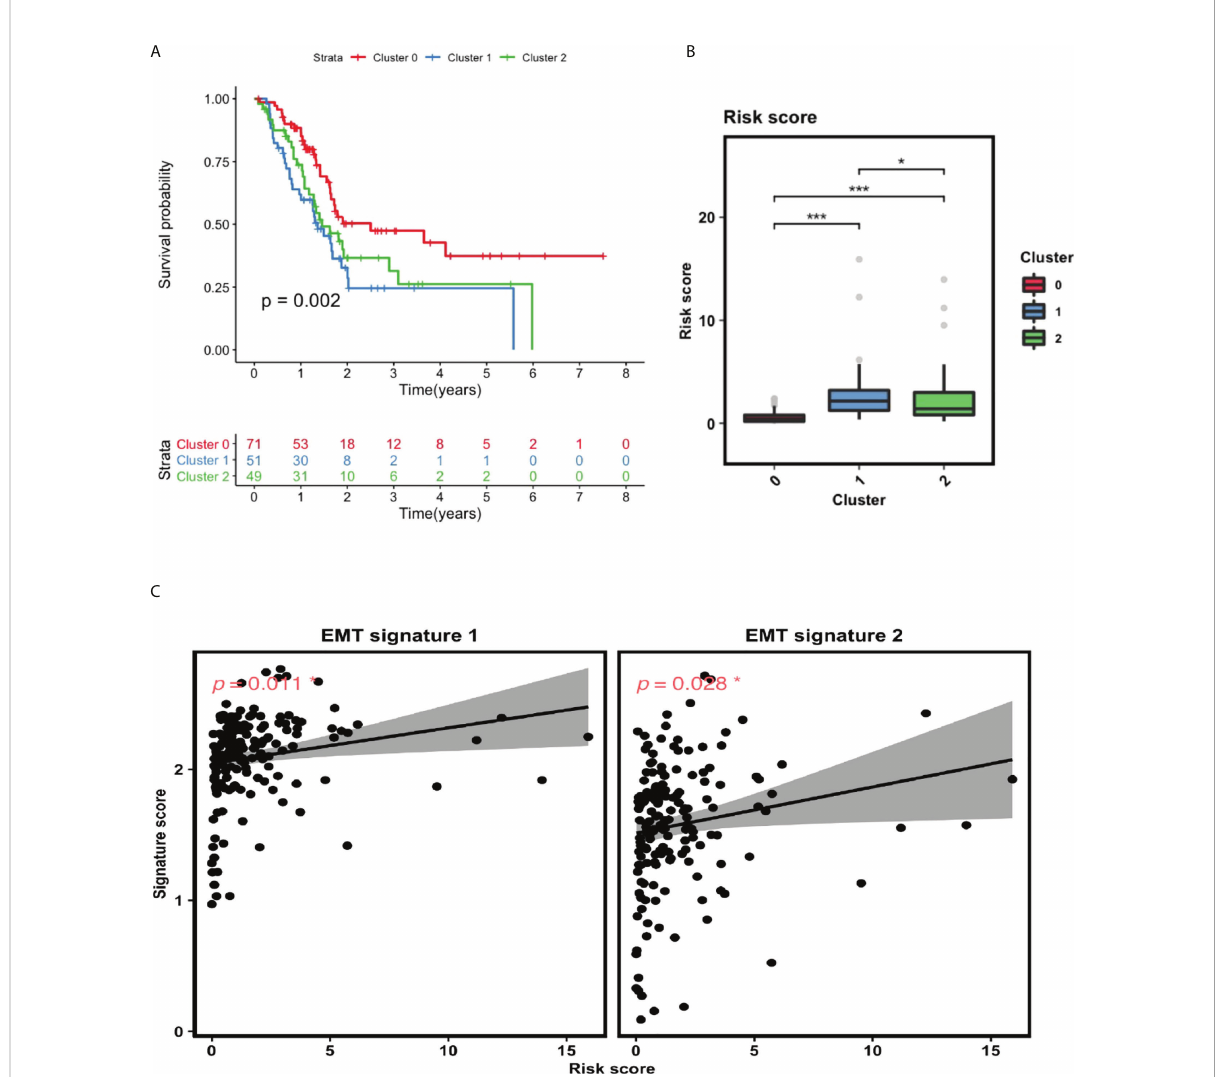
FIGURE 6 GILncSig is tightly linked to EMT. (A) Survival analysis for patients in three clusters. (B) Statistical comparison of GILncSig risk scores for the patients in three clusters. (C) Pearson correlation analysis between GILncSig risk score and EMT signature score. *P< 0.05; ***P<